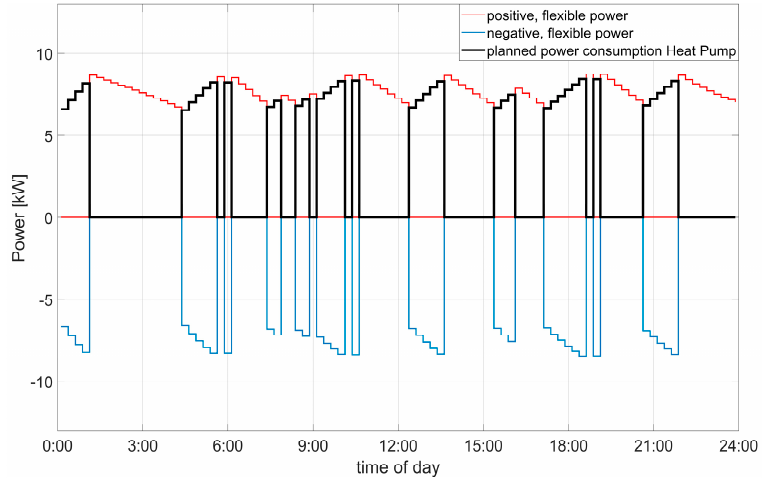
Figure 2. Positive and negative flexible power according to the scheduled power consumption per time step.